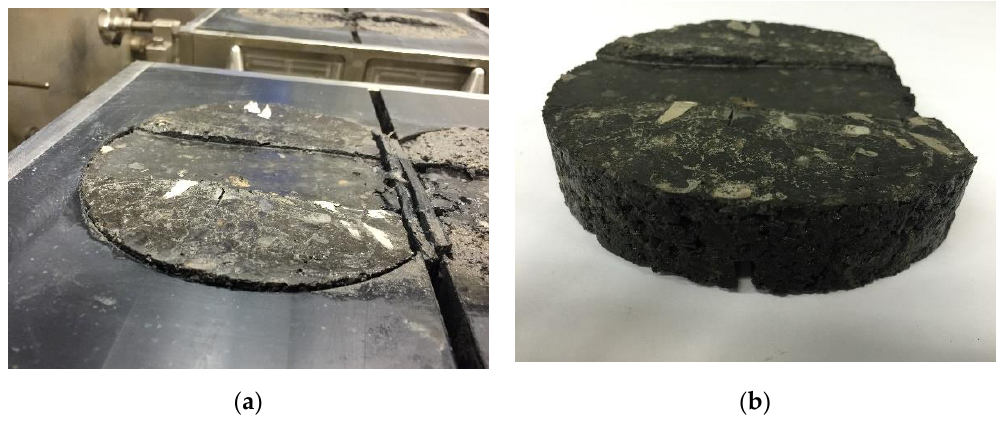
Figure 4. Specimen #1 (1-inch thickness, 10 days aging, with a notch) with surface-initiated reflective crack, ( a ) specimen within mold, and ( b ) specimen after taken out from the mold.